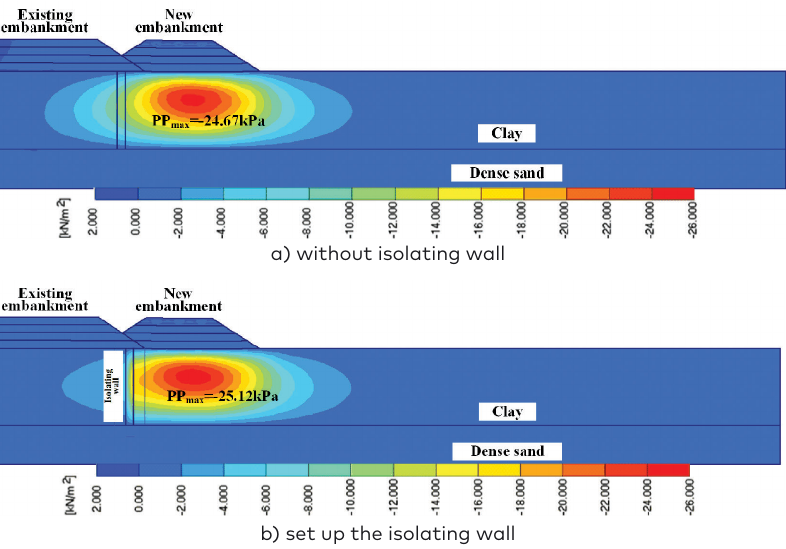
b) set up the Figure 6. Excess pore water pressure distribution during the construction period